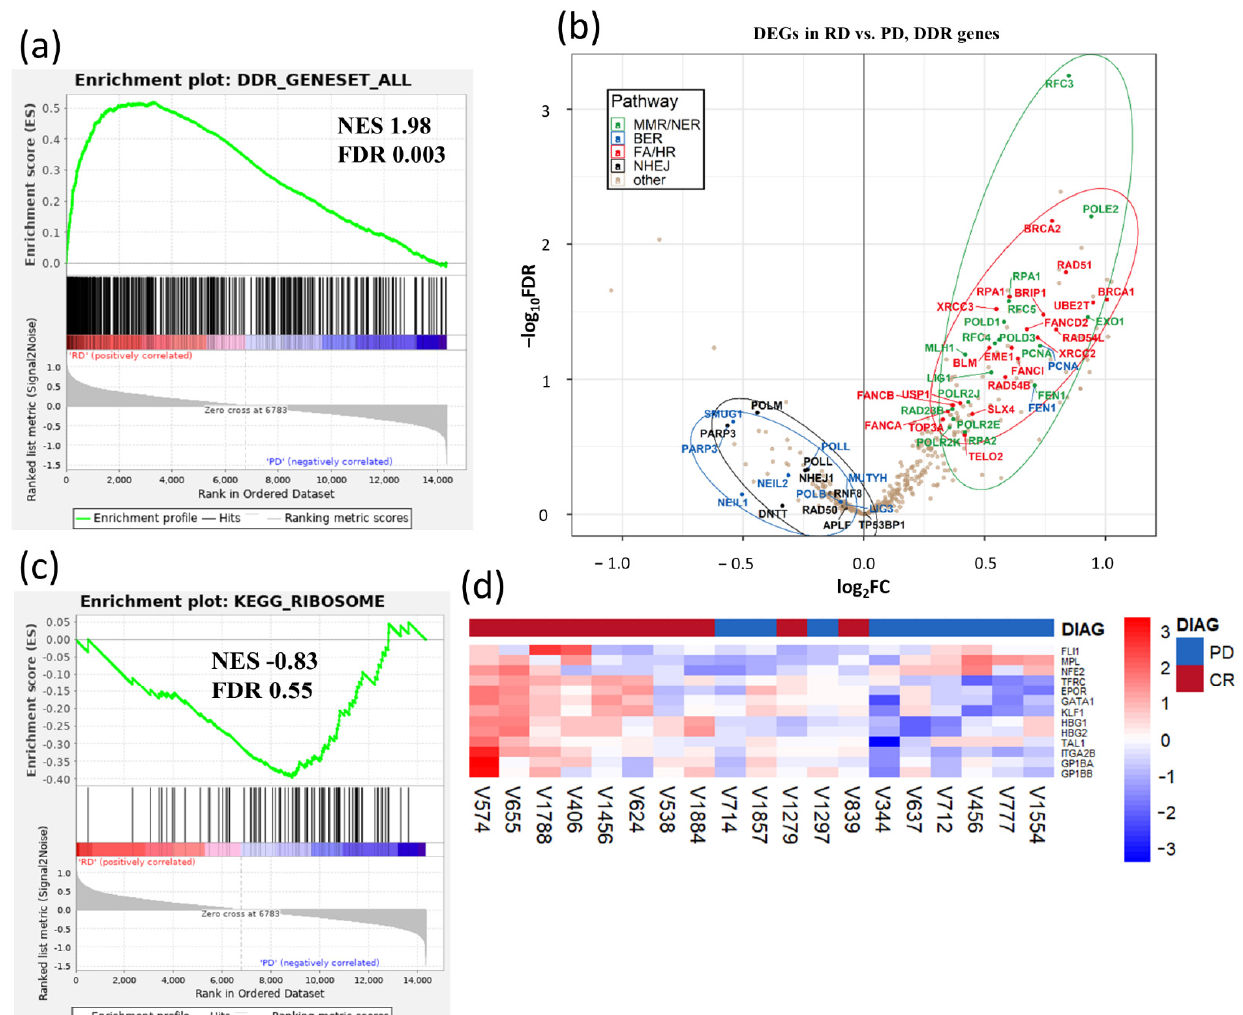
Figure 3. ( a , c ) Gene set enrichment analysis (GSEA) indicating selected gene sets enriched in CD34 + hematopoietic stem/progenitor cells (HSPCs) from AZA-responders (RD) and patients with progressive disease (PD). The top GSEA plot analyzes a set of genes implicated in DNA damage response (DDR) and repair pathways [36]. The bottom GSEA plot shows KEGG Ribosome gene set (MSigDB ref: M189)). The normalized enrichment scores (NES) and associated FDR values are depicted within the individual plots. ( b ) Volcano plot of DDR gene expression. The plot shows differential expression status of 276 DDR genes in HSPCs samples from RD vs. PD patients (for the associated heatmaps see Figure S7a,b). The most upregulated genes in the RD (i.e., downregulated in the PD) are towards the right; the most downregulated genes in the RD (i.e., upregulated in the PD) are towards the left. The subgroups of mismatch repair/nucleotide excision repair (MMR/NER), base excision repair (BER), Fanconi anemia and homologous recombination (FA/HR) and nonhomologous end-joining (NHEJ) gene clusters are labeled and circled in green/blue/red and black, respectively. The designation of genes into the subgroups is based on Pearl et al. [36]. ( d ) Hierarchical clustering heatmap of gene expression of 13 selected megakaryocytic/erythroid genes in AZA pre-treatment CD34 + HSPCs from RD and PD patients. The top bar indicates the RD patients in red and the PD patients in blue.